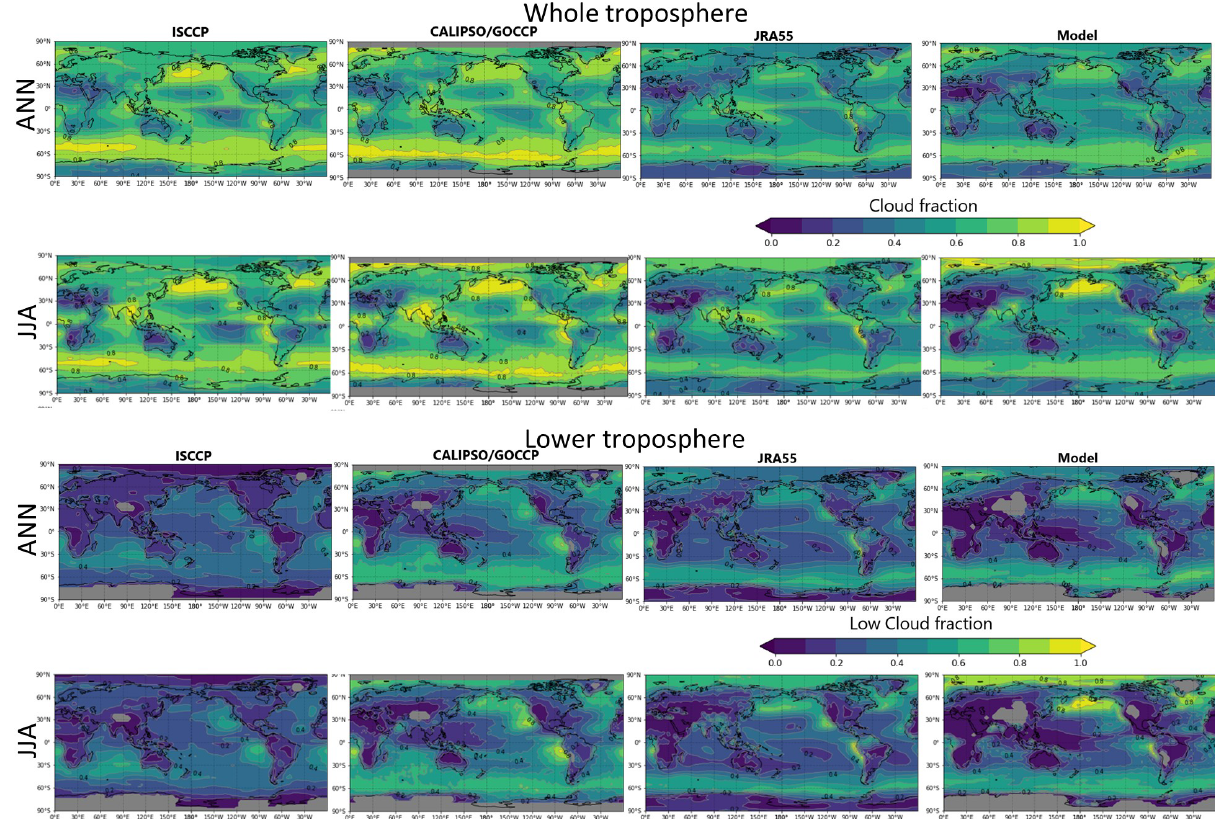
Figure 2. Comparisons for cloud fraction in the whole troposphere (first and second rows) and lower troposphere (third and fourth rows). ANN denotes annual mean, and JJA denotes June + July + August mean. The first column is for ISCCP (2000–2009), the second column is for CALIPSO/GOCCP (2007–2017), and third and fourth columns are for JRA55 and CHASER (2000–2015), respectively. Color bars are the same for all panels. In ISCCP and CALIPSO data, the pressure boundary layer of the low troposphere is > 680hPa. In JRA55, the low troposphere was defined as 850–1100hPa of